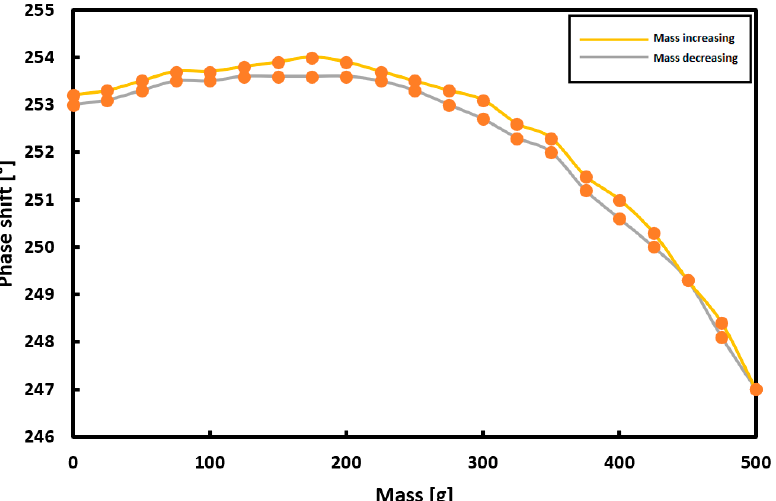
Figure 7. The results of measuring the phase shift between the set and the measured signal for a variable load on the plate.